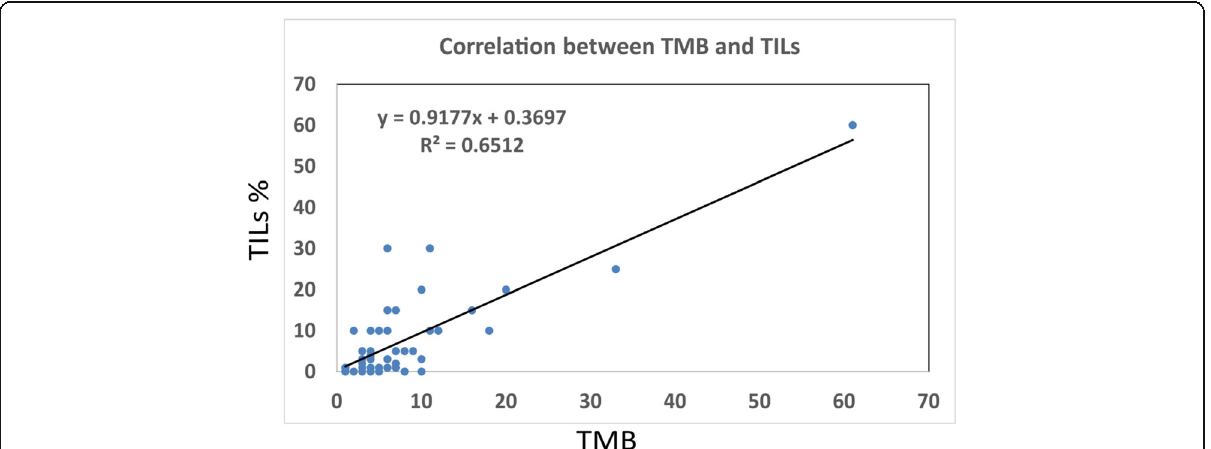
Fig. 1 Correlation between tumor mutation burden (TMB) and tumor infiltrating lymphocytes (TILs). The Pearson correlation coefficient ( r ) for TMB and TILs was 0.80696 ( n = 57; P < .0001). (y = 0.9177x+ 0.3697, R 2 =